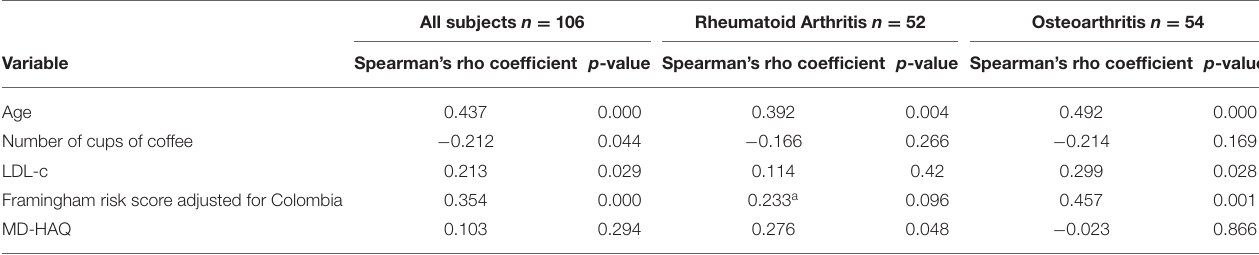
TABLE 5 | Correlations between vascular age and clinical and laboratory variables.